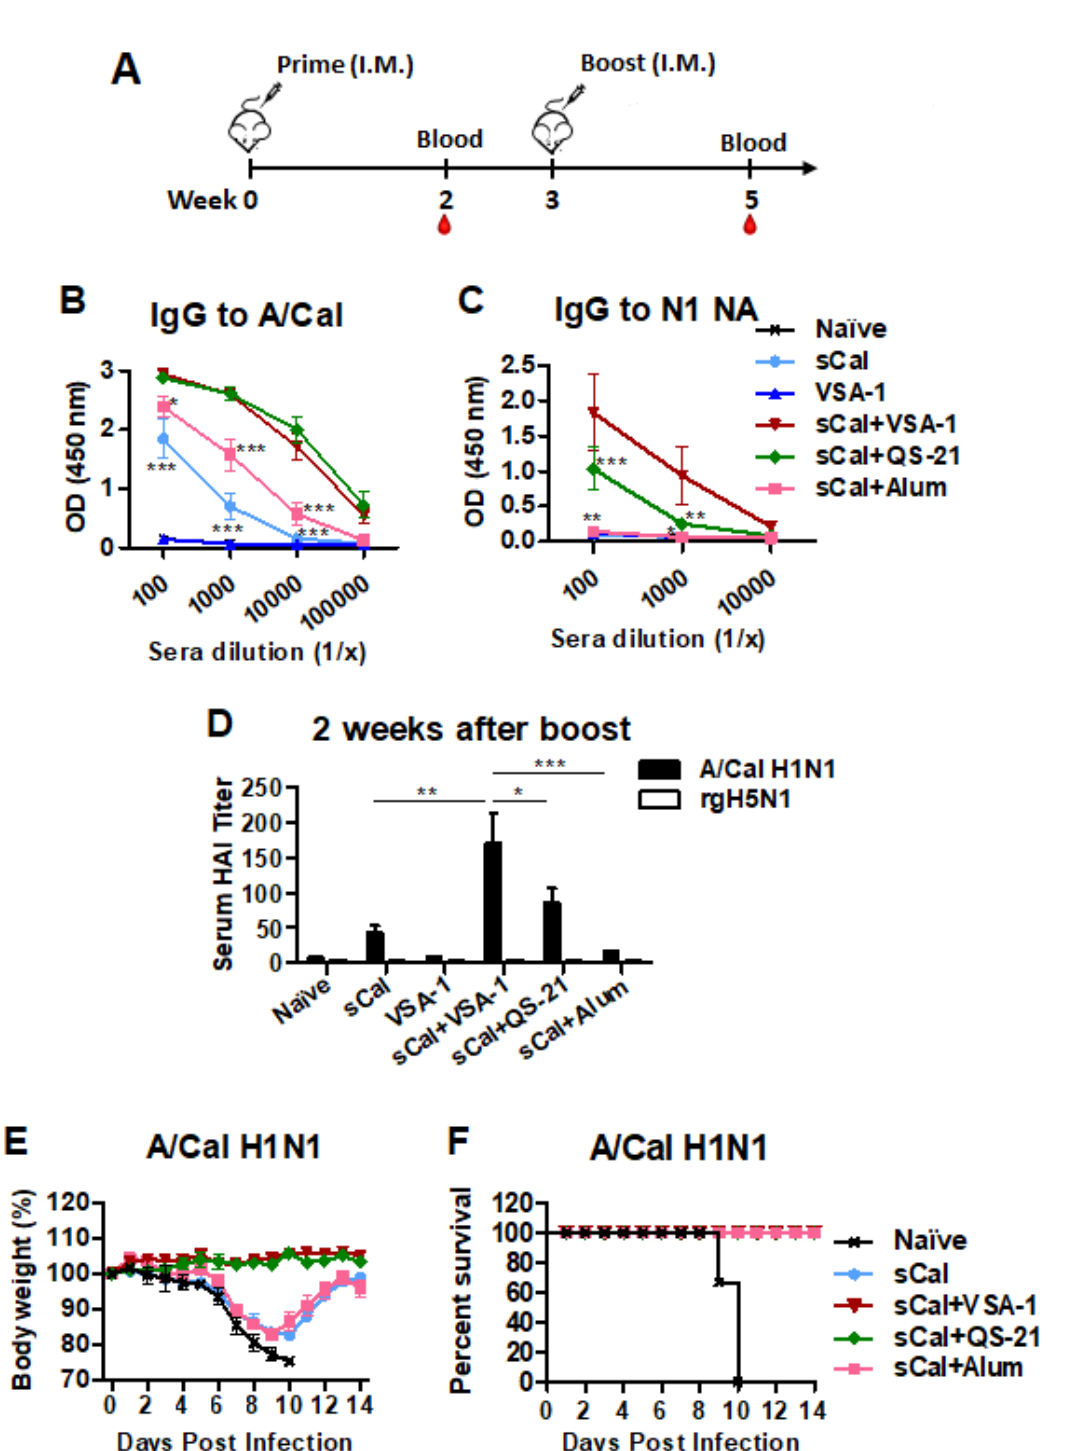
Figure 5. VSA-1-adjuvanted prime-boost sCal vaccination enhances IgG antibodies, HAI titers, and homologous protection. ( A ) Immunization scheme ( n = 7). ( B ) A/Cal H1N1 virus-specific IgG and isotype antibody levels in boost sera. ( C ) N1 NA-specific IgG antibody levels in boost sera. ( D ) HAI titers against A/Cal H1N1 and rgH5N1 viruses in boost sera. ( E , F ) Body weights and survival rates to determine the role of boost antisera in protection. Error bars indicate the mean ± SEM. *; p < 0.05, **; p < 0.01, ***; p < 0.001 compared to the sCal + VSA-1